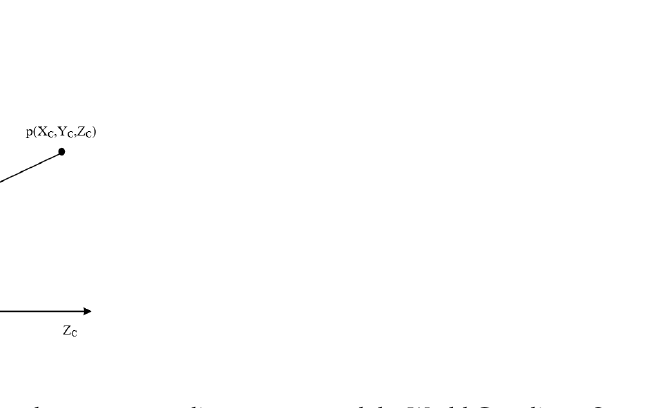
Figure 3. Relationship between the camera coordinate system and the World Coordinate System.